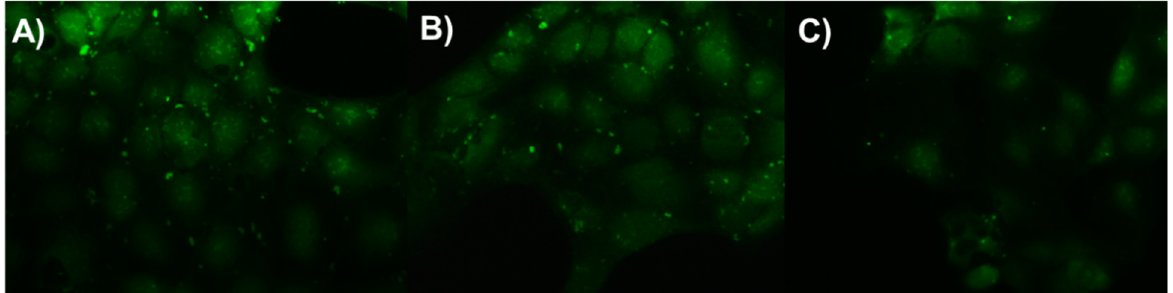
Figure 3. Bacterial neutralization efficacies of peptides: ( A ) untreated; ( B ) 5 µM mCA4-4; ( C ) 5 µM mCA4-5. The fluorescence images were taken upon incubation of GFP-expressing bacteria with peptide samples for 5 h.